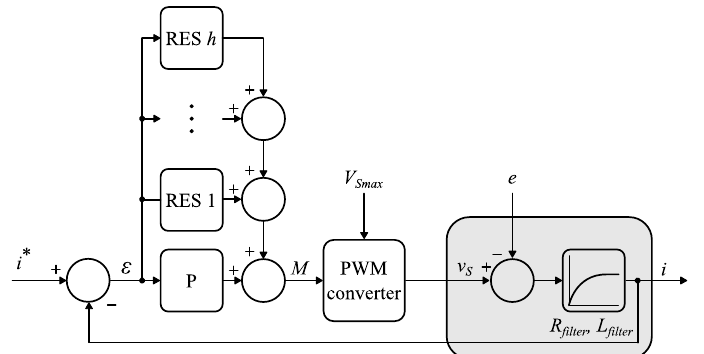
Figure 5. Block diagram of load current harmonic control with proportional (P) and multiple resonant controllers (RES 1–RES h , where h denotes the highest controlled harmonic).